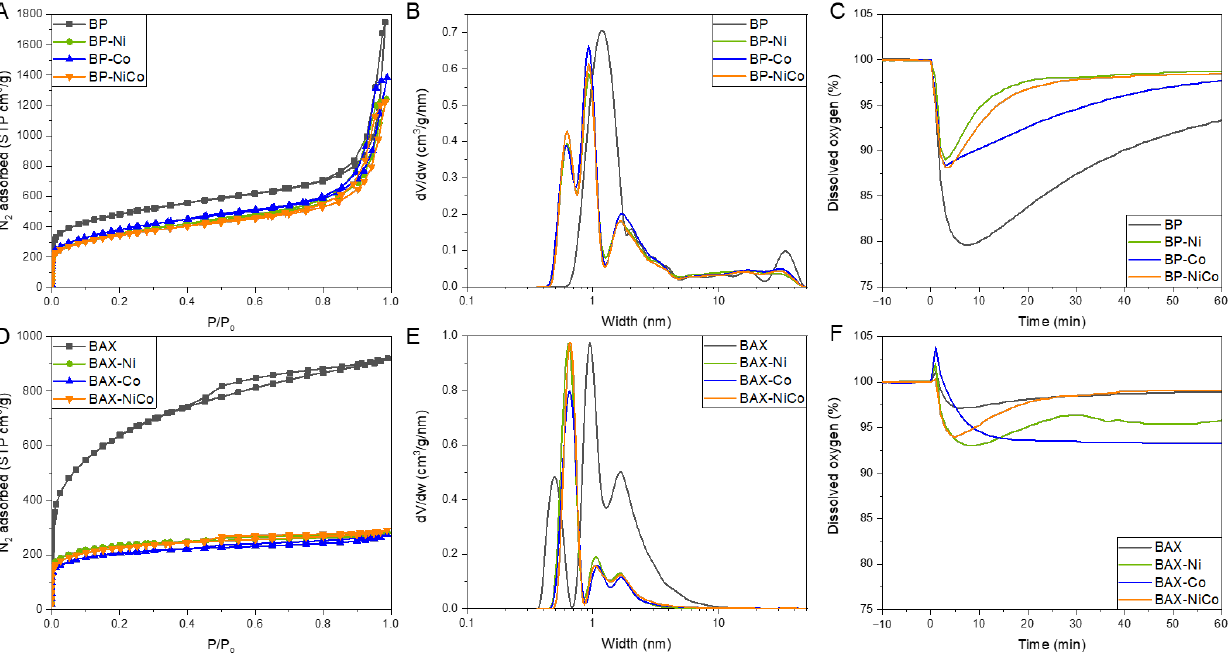
Figure 10. N 2 adsorption isotherms for the BP series ( A ) and the BAX ones ( C ); pore size distribu- tions for the BP series ( B ) and the BAX ones ( D ); adsorption of oxygen from solution on the BP series ( E ) and the BAX ones ( F